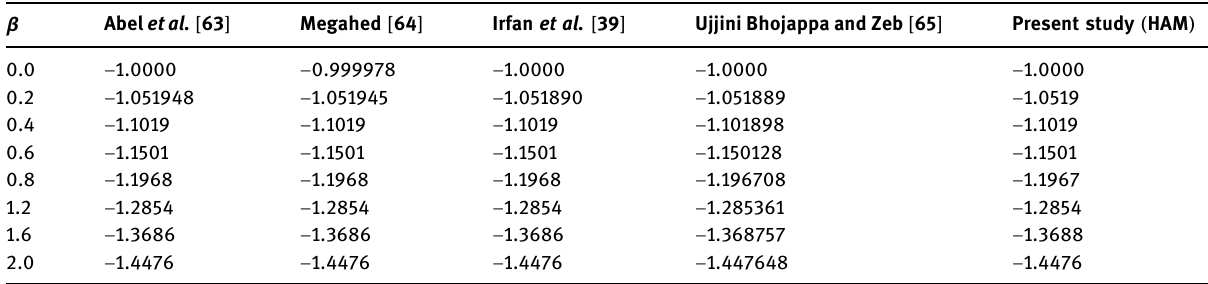
Table 3: Comparison of f ″ 0 ( ) with the works of Abel et al. [ 63 ] , Megahed [ 64 ] , Irfan et al. [ 39 ] , and Ujjini Bhojappa and Zeb [ 65 ] in the limiting case when A